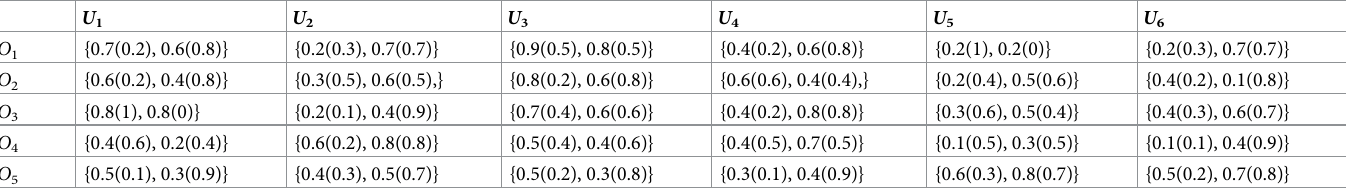
Table 4. Normalize PHF matrix Y 1 given by the first expert.